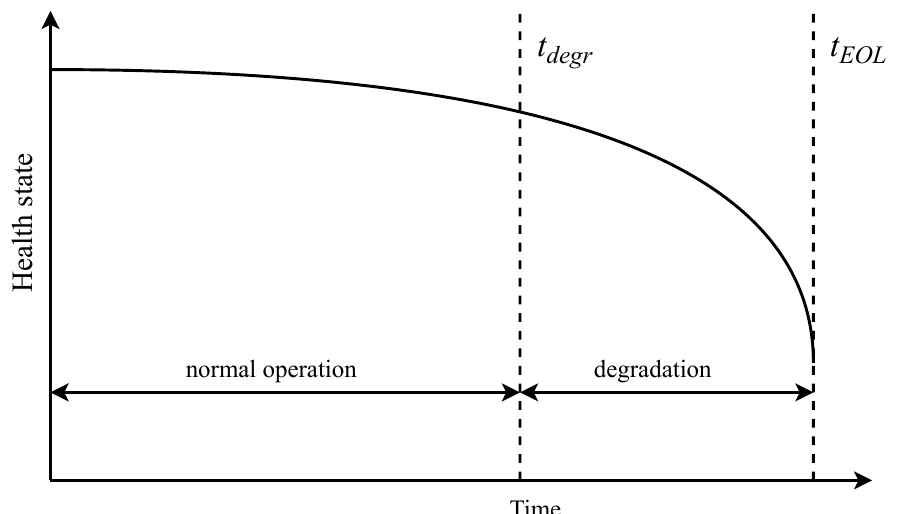
Figure 5. Degradation process visualization (adapted from [41]).